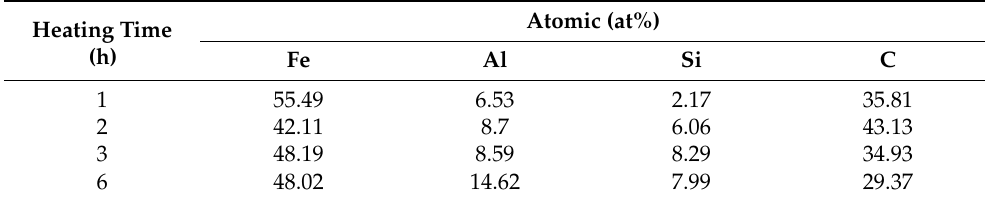
Table 5. Composition of the synthesis metals for the sample (C/O =